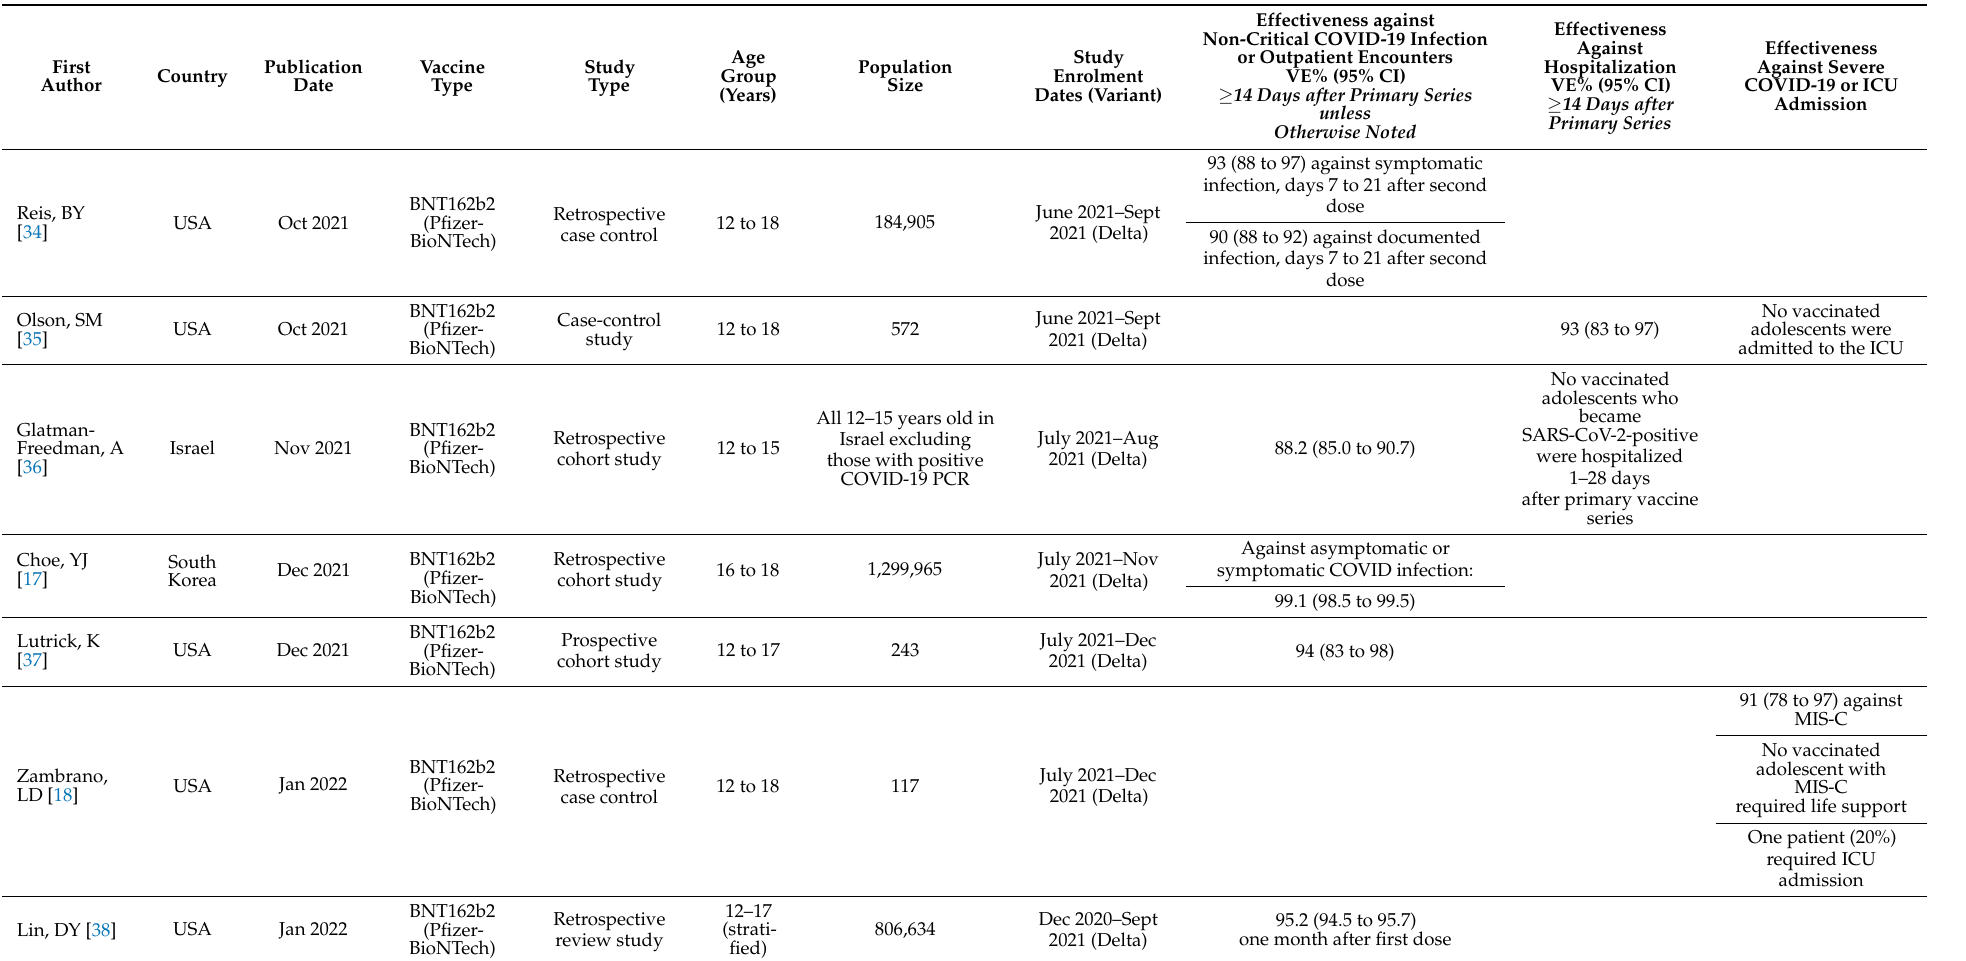
Table 2. Studies included in the vaccine effectiveness review of the